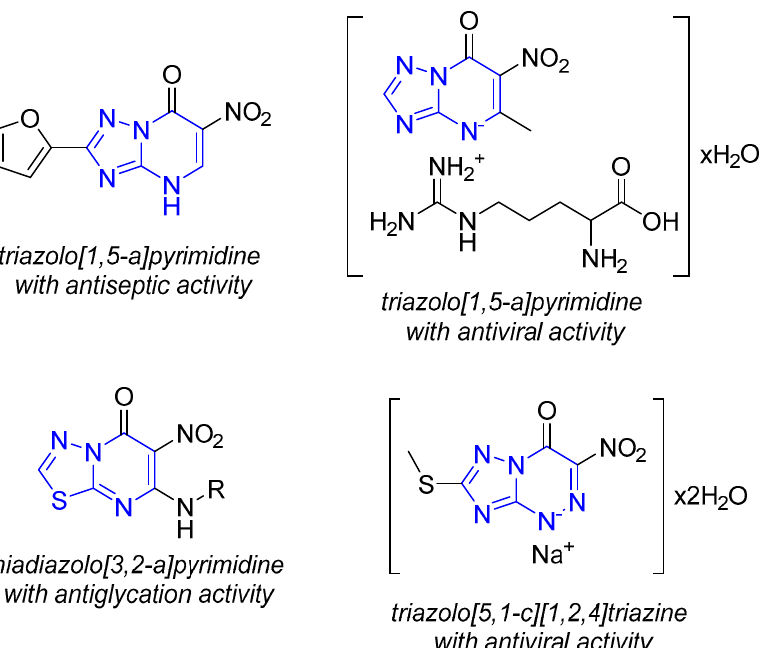
Figure 1. Examples of biologically active